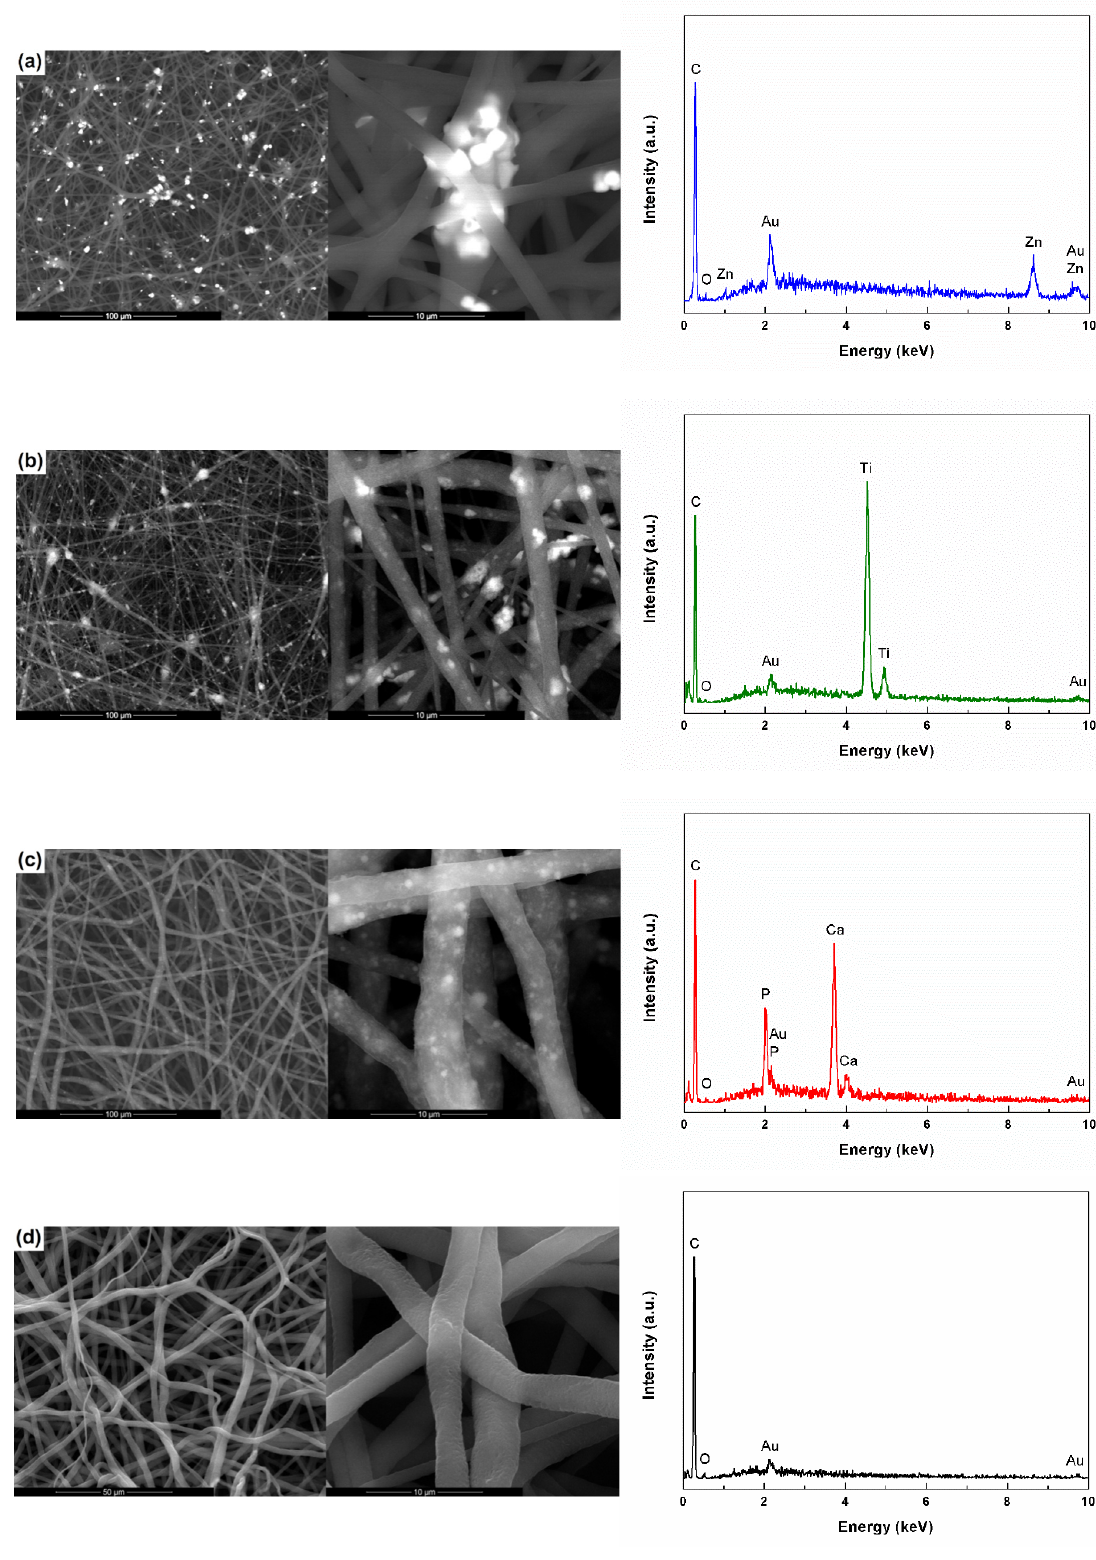
Figure 2. SEM images (left) and EDX spectra (right) of the composite and unitary scaffolds: ( a ) PCL- ( b ) PCL-TiO 2 , ( c ) PCL-HAp and ( d ) ZnO, ( b ) PCL-TiO 2 , ( c ) PCL-HAp and ( d ) PCL.